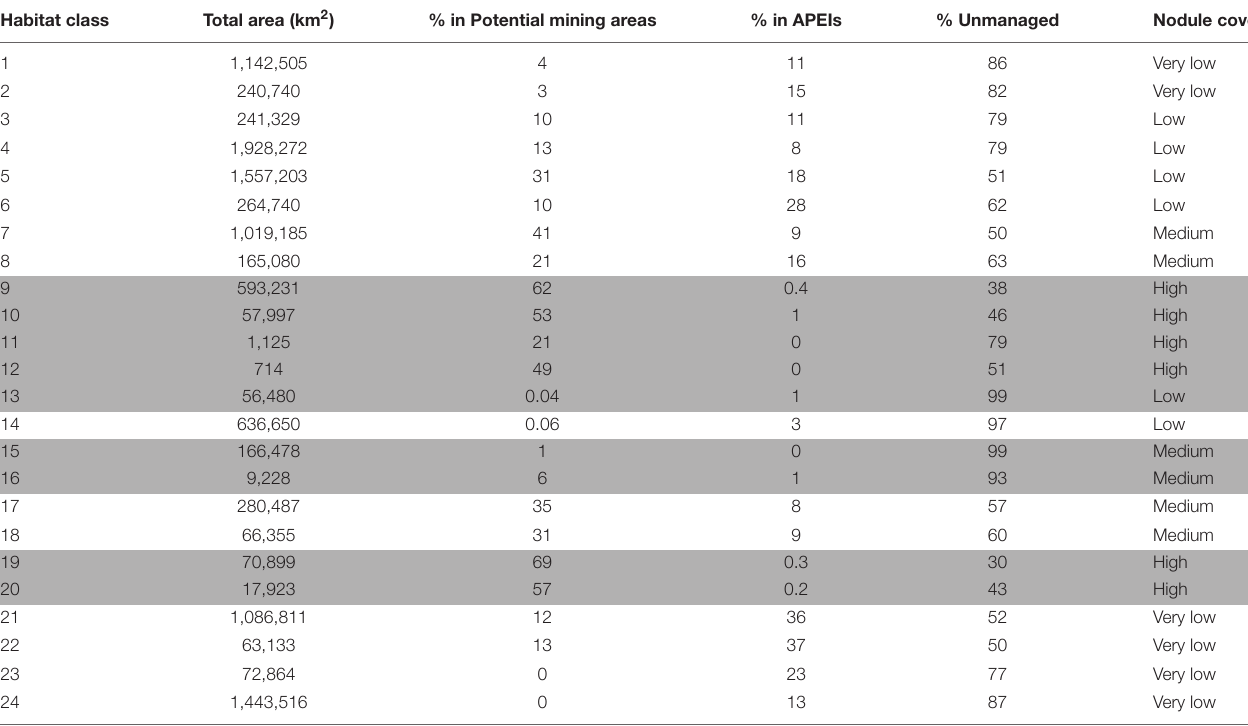
TABLE 4 | Total extent of each habitat class, and percent located in potential mining areas (exploration and/or reserved areas), Areas of Particular Environmental Interest (APEI), and unmanaged areas as of June